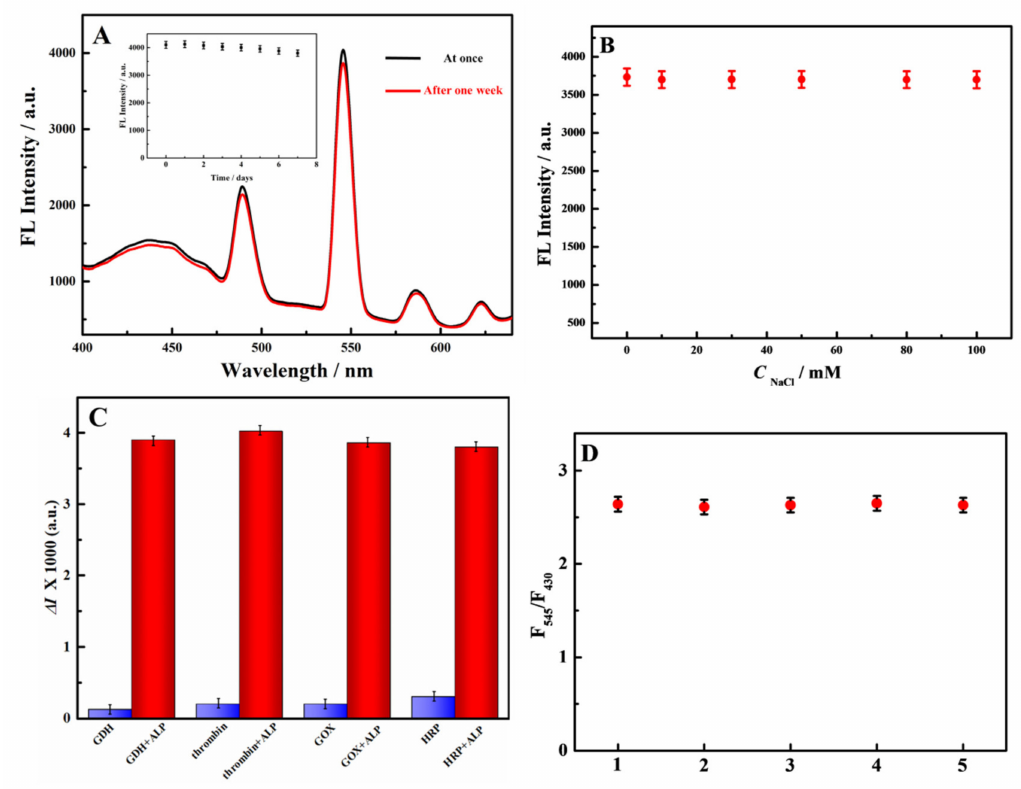
Figure 5. ( A ) The stability of Cu NCs@Tb-GMP after one week; the inset shows the stability each day of the week. ( B ) The salt tolerance of Cu NCs@Tb-GMP. ( C ) The selectivity of other interfering substances over ALP: GDH, thrombin, GOx and HPR. ( D ) The repeatability of Cu NCs@Tb-GMP over five